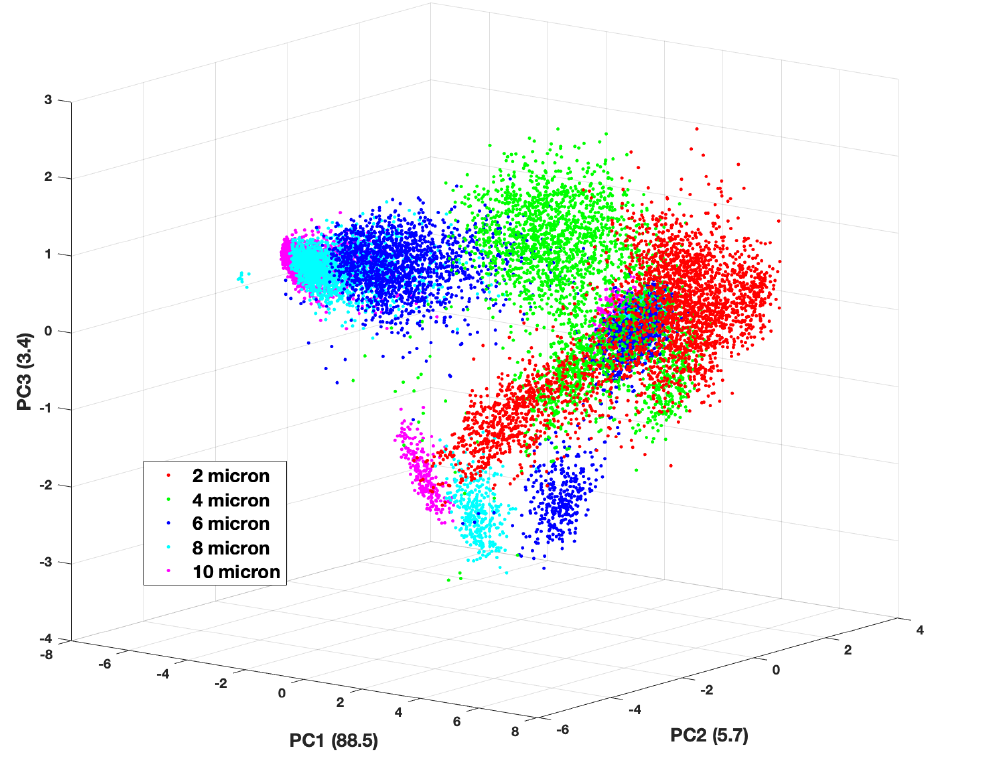
Figure 6. Three-dimensional plot of the scores values for first 3 principal components of the forward scattering dataset by cluster